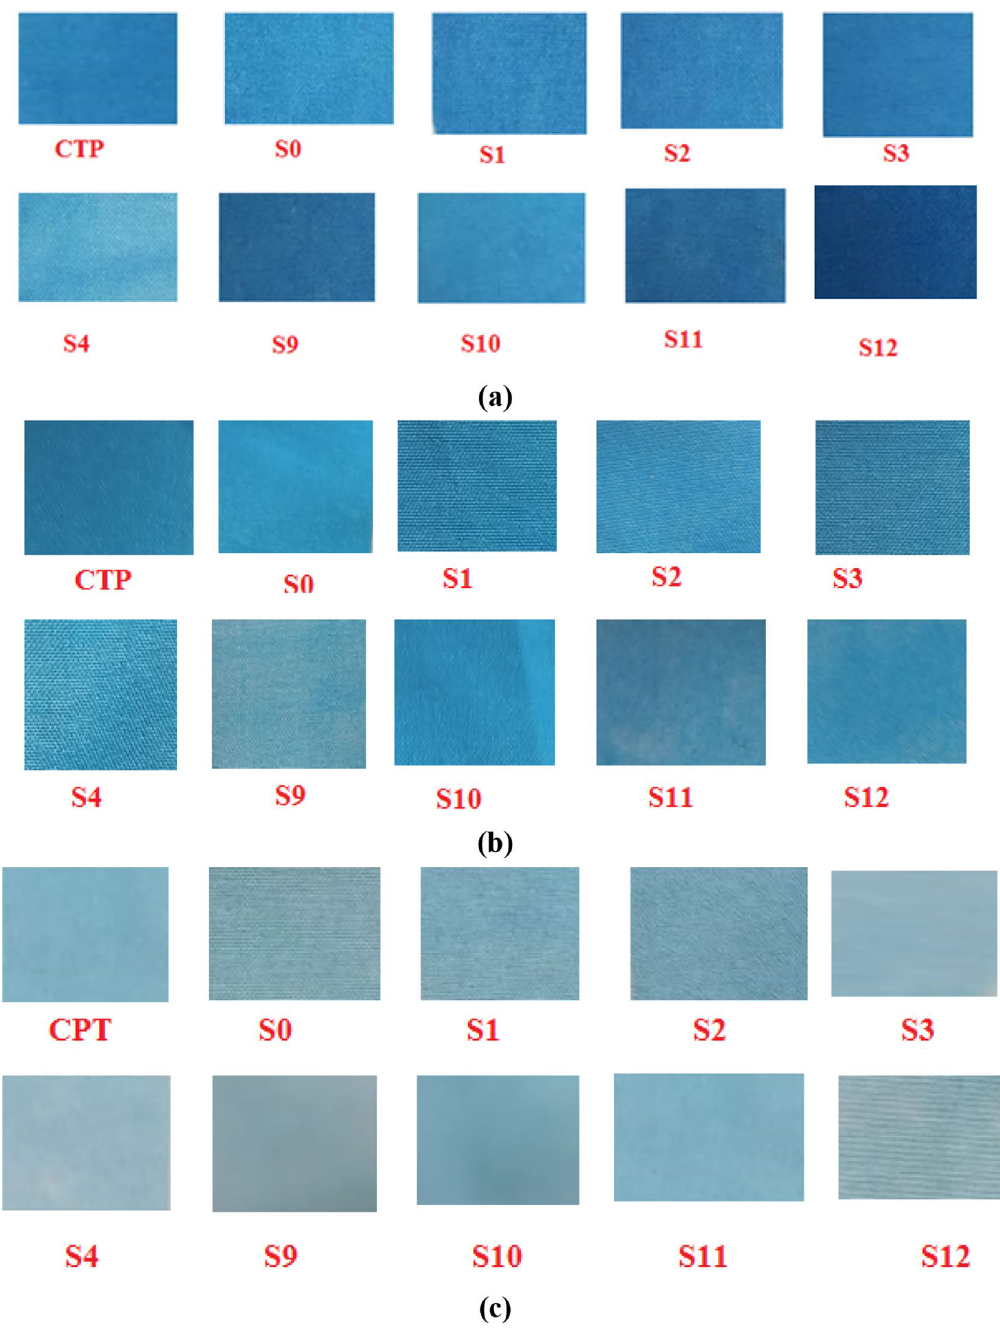
Figure 8. Photographic image of heat transfer-printed polyester fabrics at ( a ) 3%, ( b ) 2% and ( c ) 1% dye